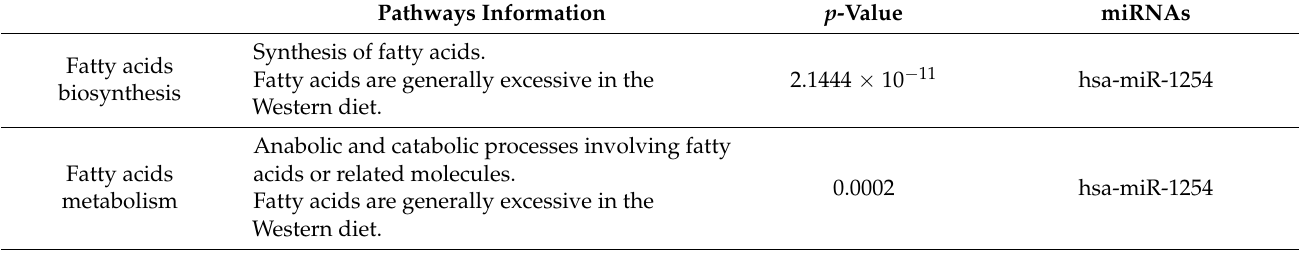
Table 5. Union analysis performed with DIANA–miRPath v.3. Pathways